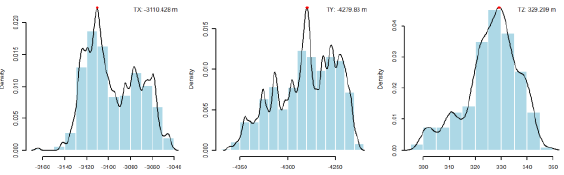
Figure 4 : Translation estimates. Given the highly imprecise GPS coordinates, translations estimates are very variable. In order to reach some coherence, we picked the maximum of the kernel density estimation (with 2m bandwidth). Distributions are clearly non uni-modal and even though we picked the highest kernel density estimate, at least two values may work out for X and Y coordinates.